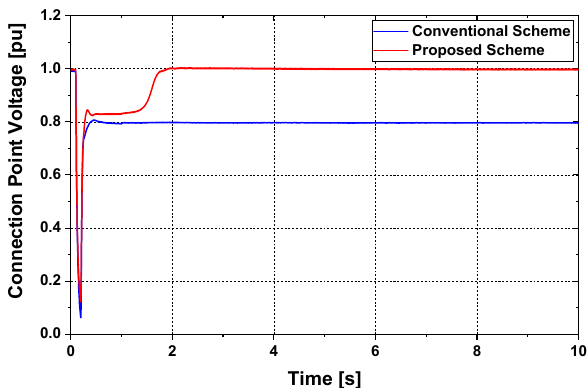
Figure 11. Voltage performance at the connection point.